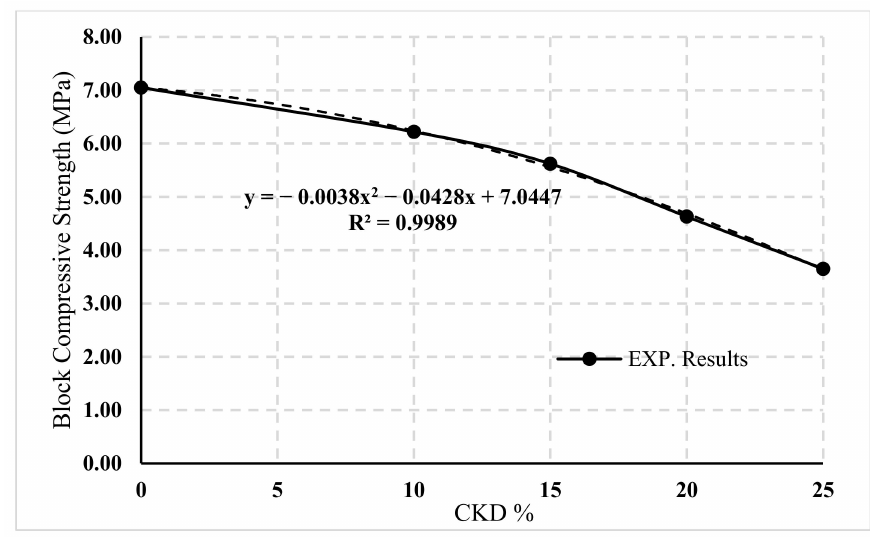
Figure 7. Relation between the block compressive strength and the CKD percentage.